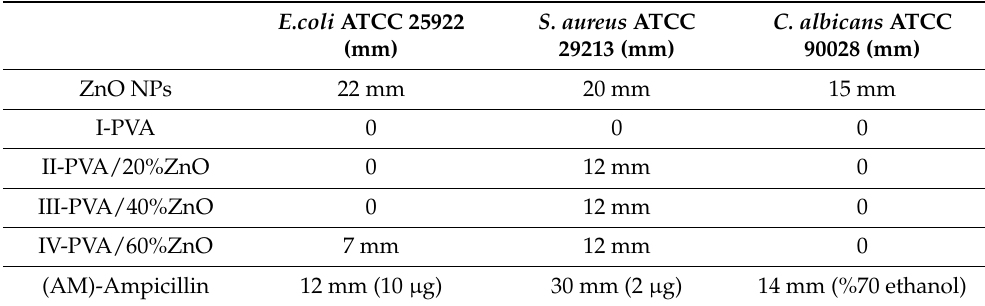
Table 3. Measurement of inhibition zones formed due to the antimicrobial activity of ZnO NPs and 4 different concentrations of PVA/ZnO fibers in E. coli , S. aureus , and C. albicans by disk diffusion method.